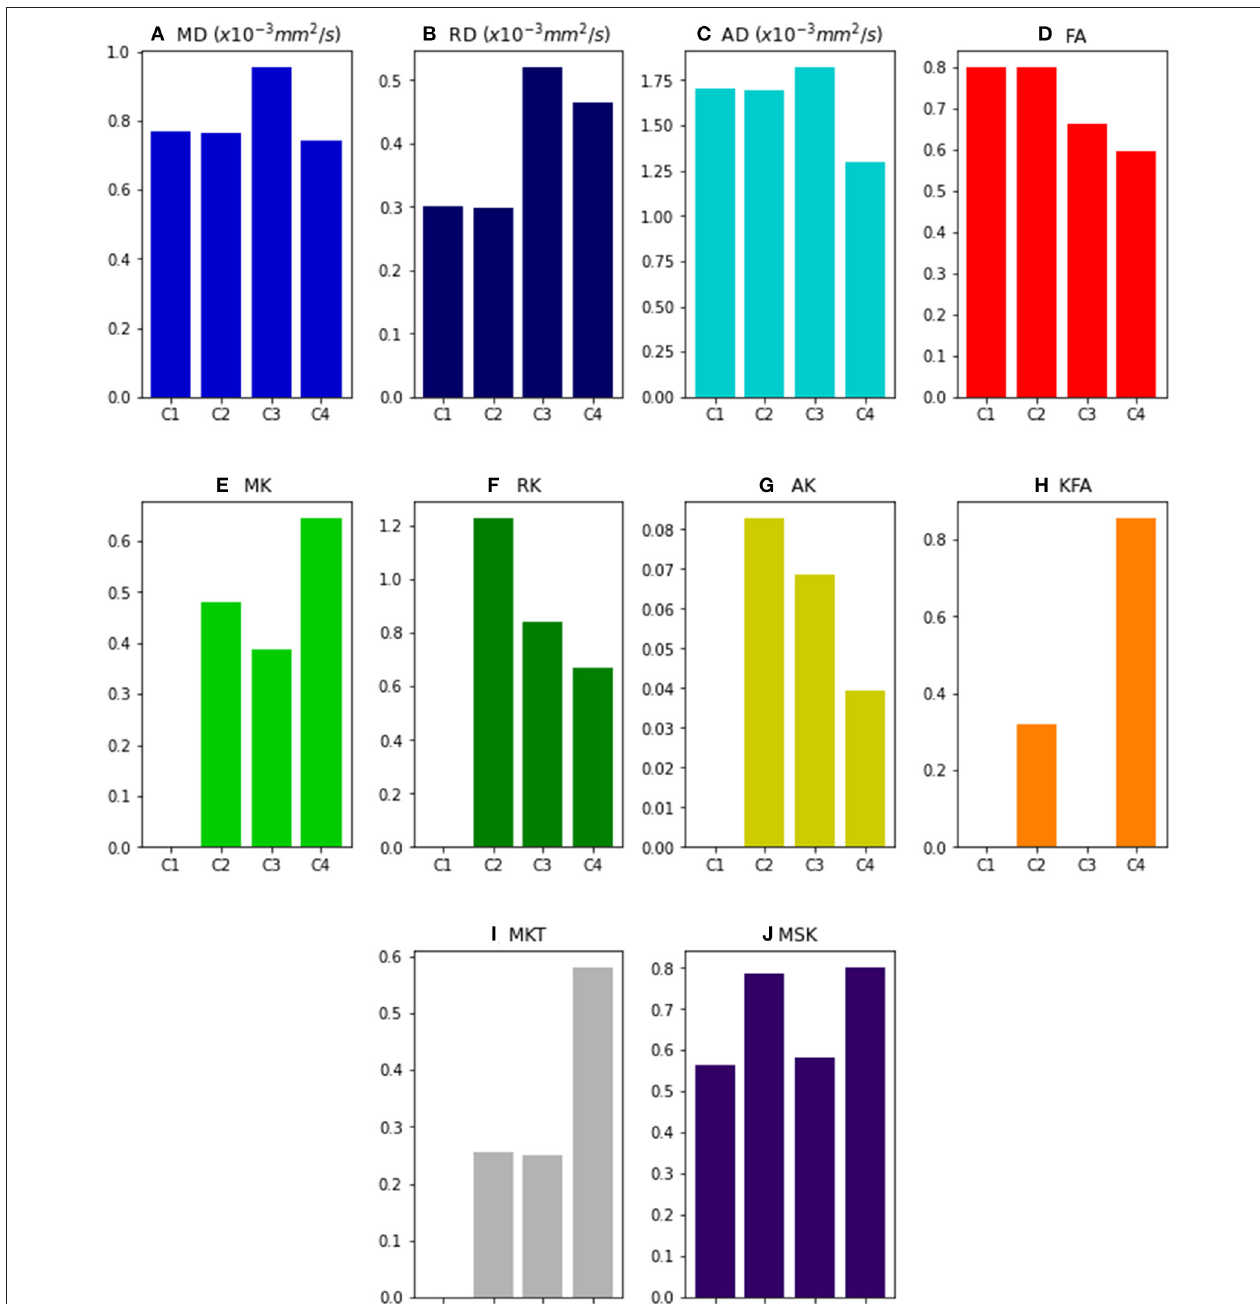
FIGURE 2 | DKI and MSDKI diffusion and kurtosis metrics for the four voxel simulations: (A) Mean diffusivity; (B) Radial diffusivity; (C) Axial diffusivity; (D) Fractional Anisotropy; (E) mean kurtosis; (F) Radial Kurtosis; (G) Axial kurtosis; (H) Kurtosis Fractional Anisotropy; (I) Mean Kurtosis Tensor; (J) Mean signal kurtosis.